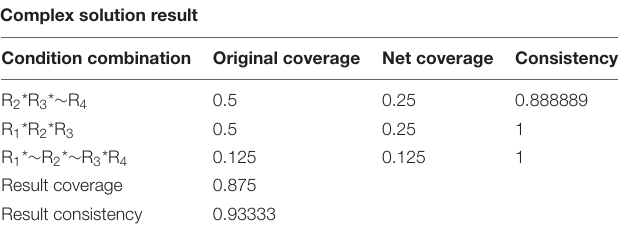
TABLE 4 | fsQCA output: complex solution result. Complex solution result